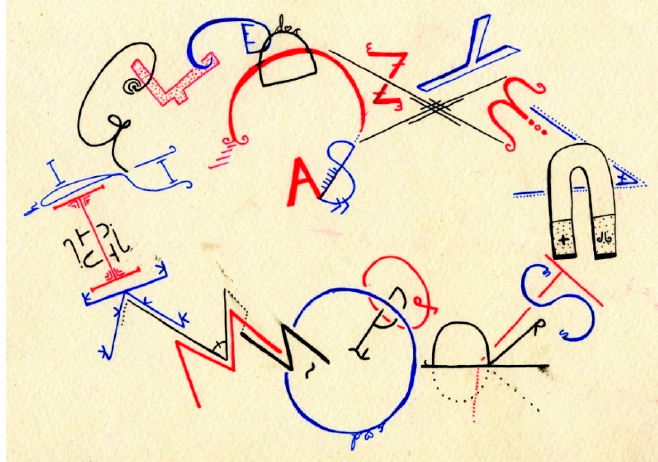
Figure A1. “Alphabet”. The 26 letters of the English alphabet in a counter-clockwise loop. Red, blue and black pens, white paper. Drawing made by authors. License: Creative Commons Attribution-NonCommercial 4.0 International.